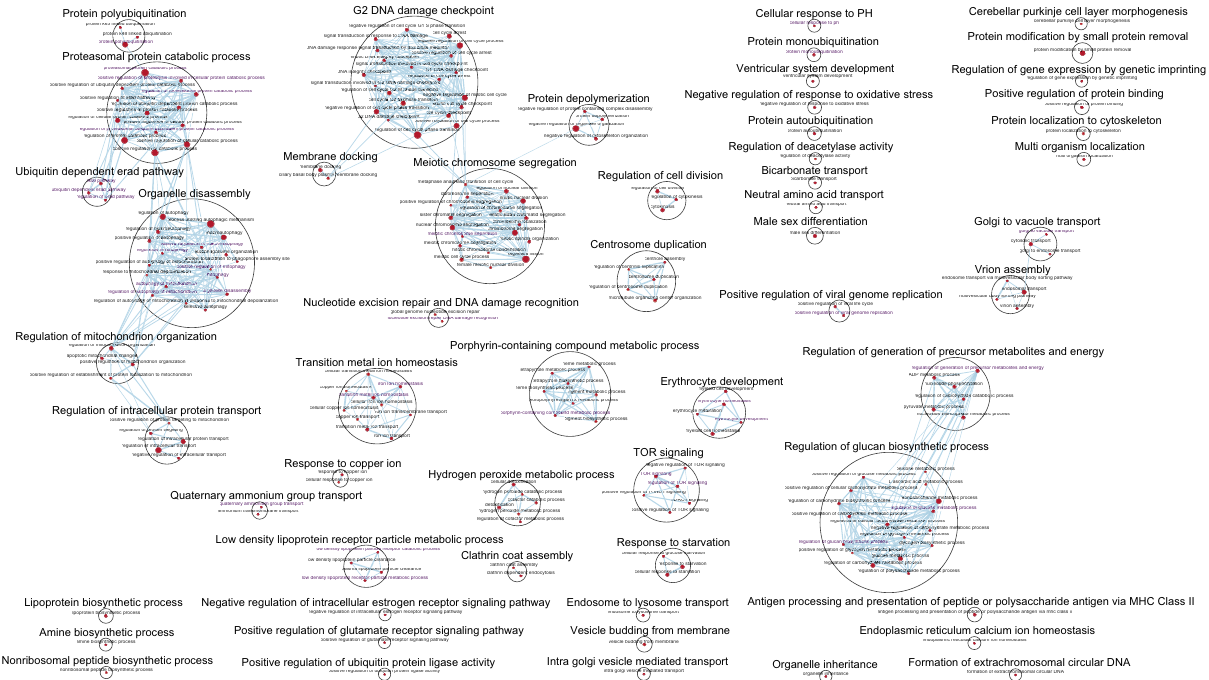
Figure 3. Biological network of the MGI RNA-seq dataset following Gene Ontology (biological process) gene set enrichment analysis in GSEA (v4.0.3) and visualisation in Cytoscape (3.8.0). Each circle (node) represents a gene set and two nodes are connected by lines (edges) indicating shared genes. The size of a node and width of an edge are proportional to the number of genes enriched in a gene set and the number of genes shared between gene sets, respectively. Gene sets that are similar were annotated and clustered to form a biological theme using the AutoAnnotate App in Cytoscape. The most significantly enriched gene set is used to label a gene set cluster, defined by NES. Red node: gene set enriched in EPO4. Purple node label: top gene sets with NES > 1.90. The enrichment map was created with pathway FDR < 0.1, nominal P < 0.05 and Jaccard Overlap coefficient > 0.375 with combined constant k =